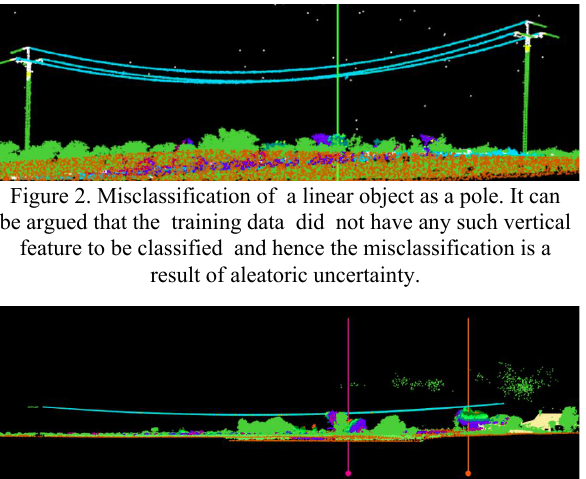
Figure 3. Misclassification of a dense segment of noise points above the cables as vegetation. Since the points are dense and hence would have been labelled by the classification algorithm in any case. Thus, it is easy to suspect epistemic uncertainty in this case.